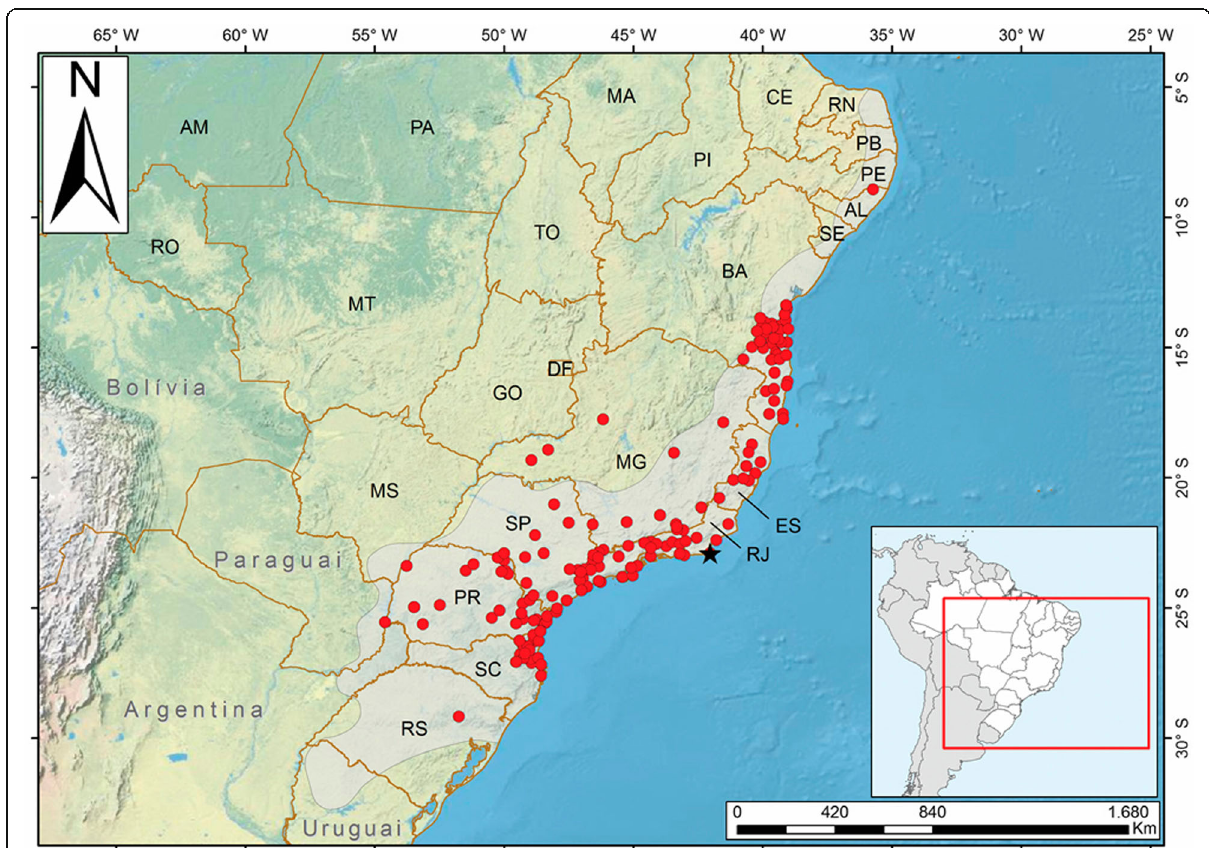
Fig. 1 Map showing the Atlantic Forest area on the Brazilian coast where Micrurus corallinus is found [7]. Copyright by Prof. Nelson Jorge da Silva Jr. Reprinted with